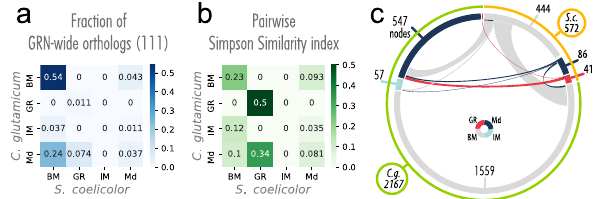
Figure 7. Conservation of the systems-level components between S. coelicolor and C. glutamicum. ( a ) NDA classification for the GRN-wide orthologs in their corresponding organism. Total matrix sum to 1. Most of the GRN-wide orthologs are classified as basal machinery in both organisms ( b ) Overlapping of the NDA classes between the two networks with reference to the smallest set. Each cell can range between 0 and 1, where 1 means one class is a subset of another, and 0 means there is no overlap at all. ( c ) Similarities between the two organisms highlight the size difference between the datasets. The color of the inner circle sections represents the NDA classes and ribbons colors represent the S. coelicolor NDA classes. Numbers represent the genes for each class and organism. Gray ribbons are the widest ones, representing that all the basal machinery of S. coelicolor with 1:1 orthology relationship with C. glutamicum is classified either as basal machinery or modular genes in C. glutamicum . This suggests that multiple basal machinery genes could be reclassified as modular components in more complete reconstructions of the S. coelicolor